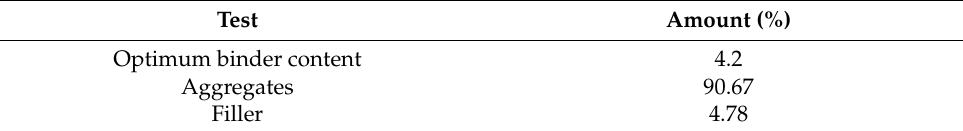
Table 2. Porous asphalt mixture proportions.